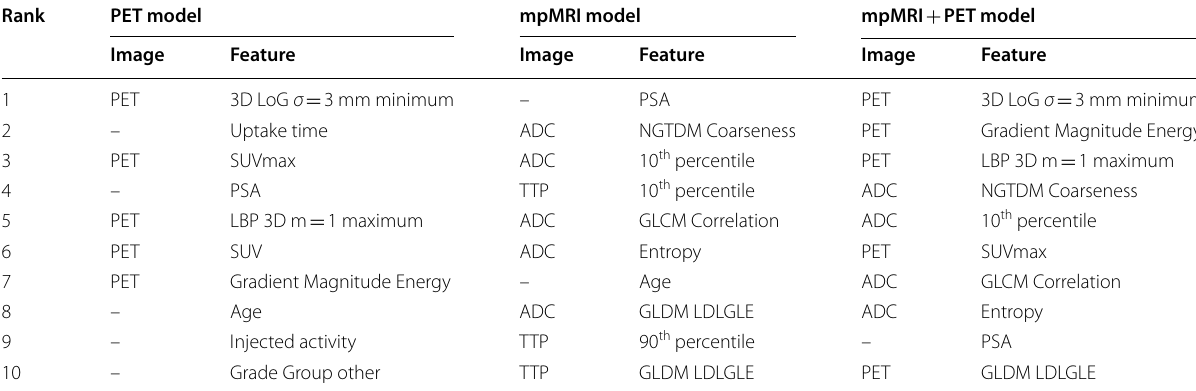
LoG Laplacian of Gaussian, LBP Local binary pattern, NGTDM Neighbouring Grey Tone Difference Matrix, GLDM Grey Level Dependence Matrix, LDLGLE Large Dependence Low Grey Level